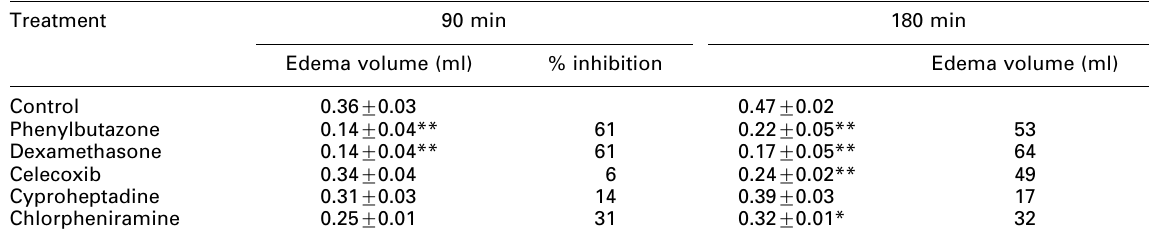
Table 2. Anti-inflammatory effect of various drugs administered orally 1 h before injecting carrageenan into the rat paw Treatment